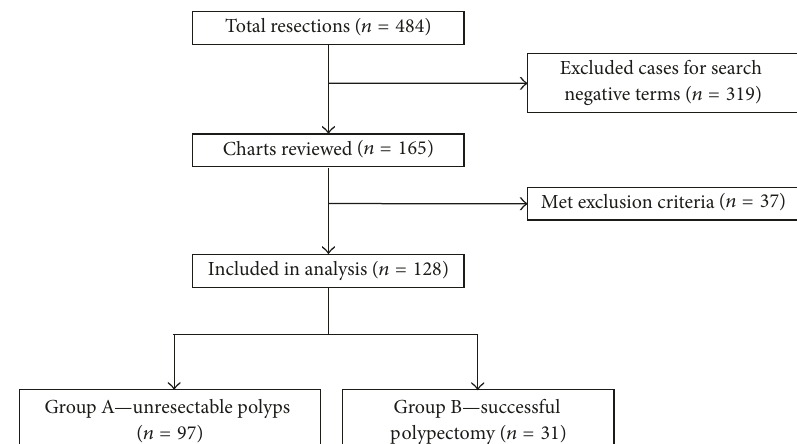
Figure 1: Patients included and excluded from a retrospective chart review of patients undergoing segmental colonic resection at St. Paul’s Hospital in Vancouver, Canada. Inclusion and exclusion of patients in a retrospective chart review of characteristics of patients who have undergone segmental colonic resection for